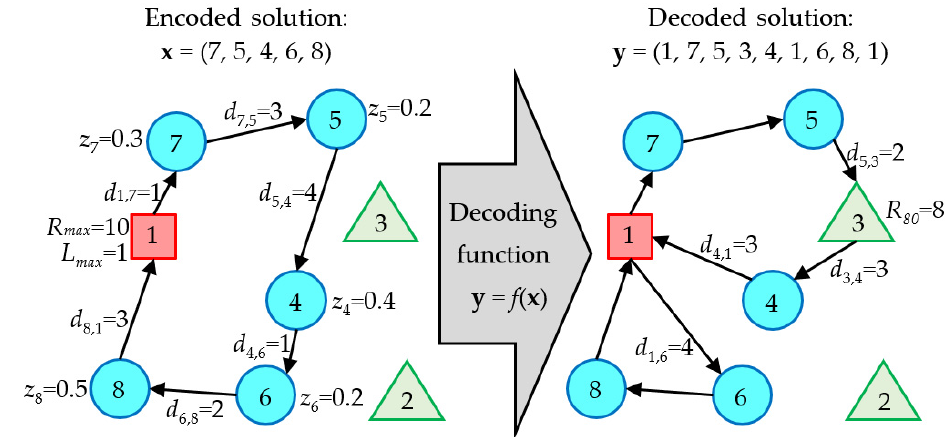
Figure 3. Example of E-VRP solution decoding.